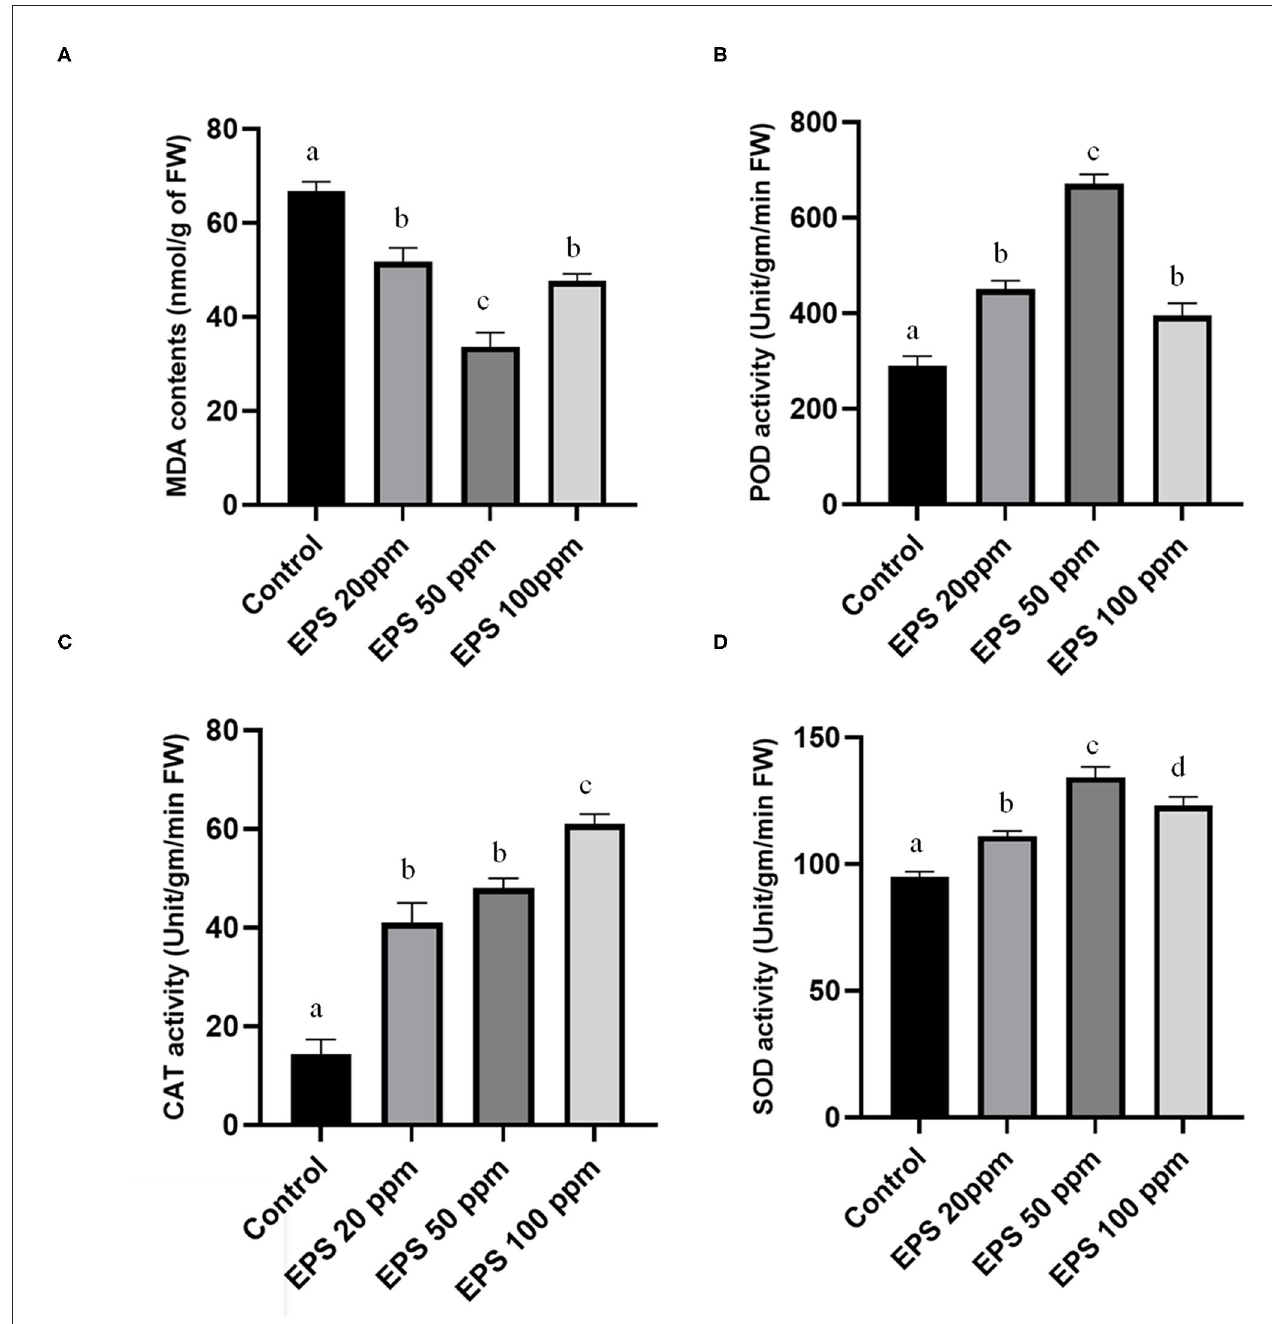
FIGURE 6 | Alteration of (A) -malondialdehyde contents (MDA), (B) -peroxidase activity (POD), (C) -catalase (CAT) activity, (D) -superoxide dismutase (SOD) activity after EPS foliar spray on Oryza sativa ssp. indica MTU 7093 swarna in comparison to control. Values on the graphs are the means ± Standard error (SE) of three replicates. Tukey’s multiple comparison test was performed. The different letters a, b, c, and d indicates significance differences in comparison to the control plant (At, P < 0.05).